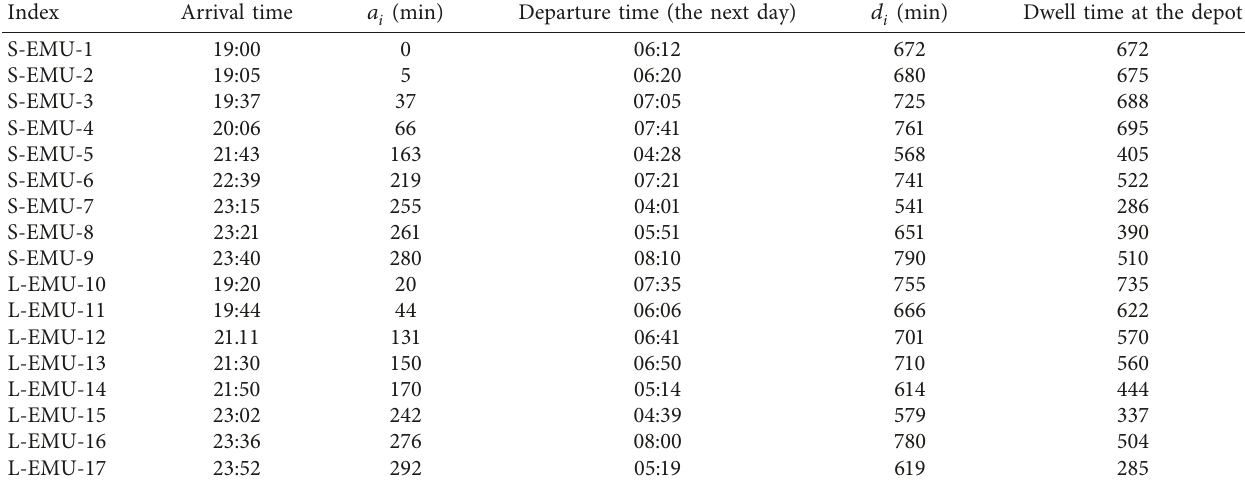
Table 3: The schedule of the EMUs.